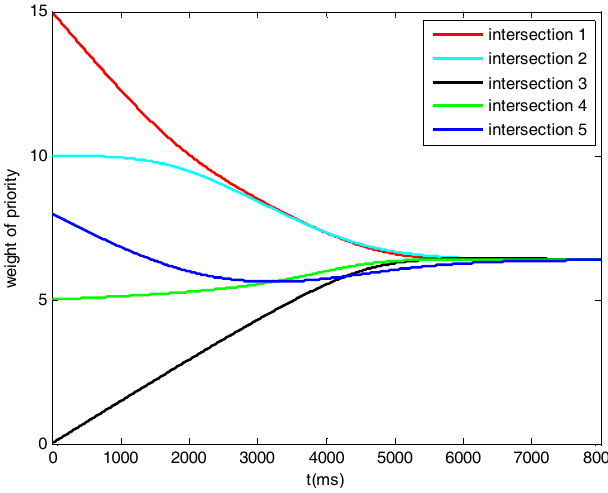
Figure 5. Simulation results of consensus algorithm with input constraints in TSP. Future Internet 2017 , 9 , 69